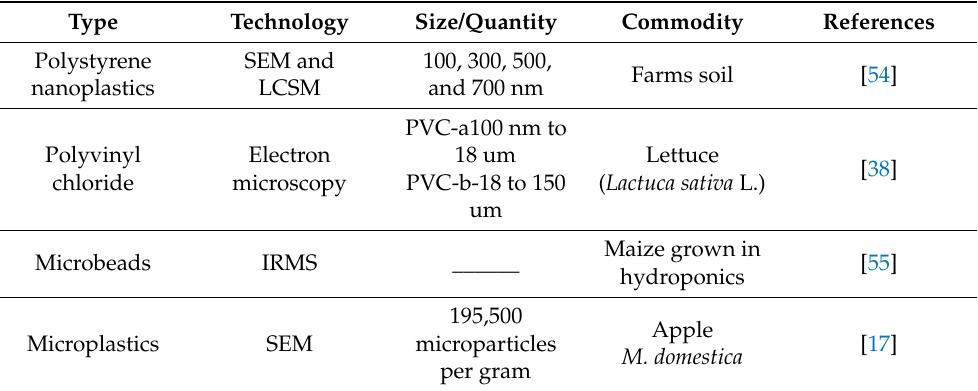
Table 2. Estimation of microplastic and their constituent by using different techniques in horticultural